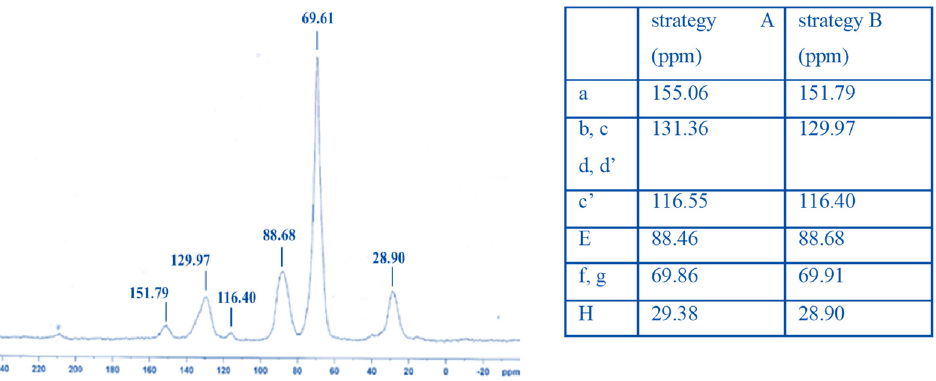
Figure 3. Solid-state 13 C CP-MAS NMR spectrum acquired for FPOP prepared by Strategy B. The Figure 3 . Solid-state 13 C CP-MAS NMR spectra acquired for FPOP prepared by Strategy B. The table table includes the comparison of both materials (Strategies A and includes the comparison of both materials (Strategies A and B).